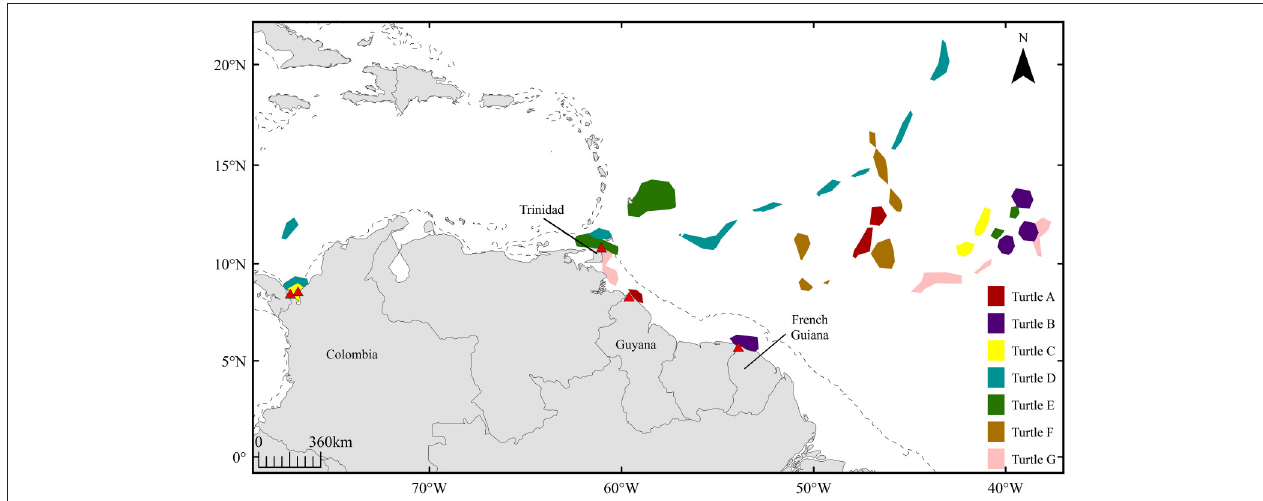
FIGURE 2 | High-use areas defined by 50% volume contours for seven female leatherbacks (turtles A-G) for 120 days prior to first seasonal nesting events; red triangles indicate corresponding nesting sites in Guyana, French Guiana, Trinidad, and Colombia. Dashed line represents 200m isobath.